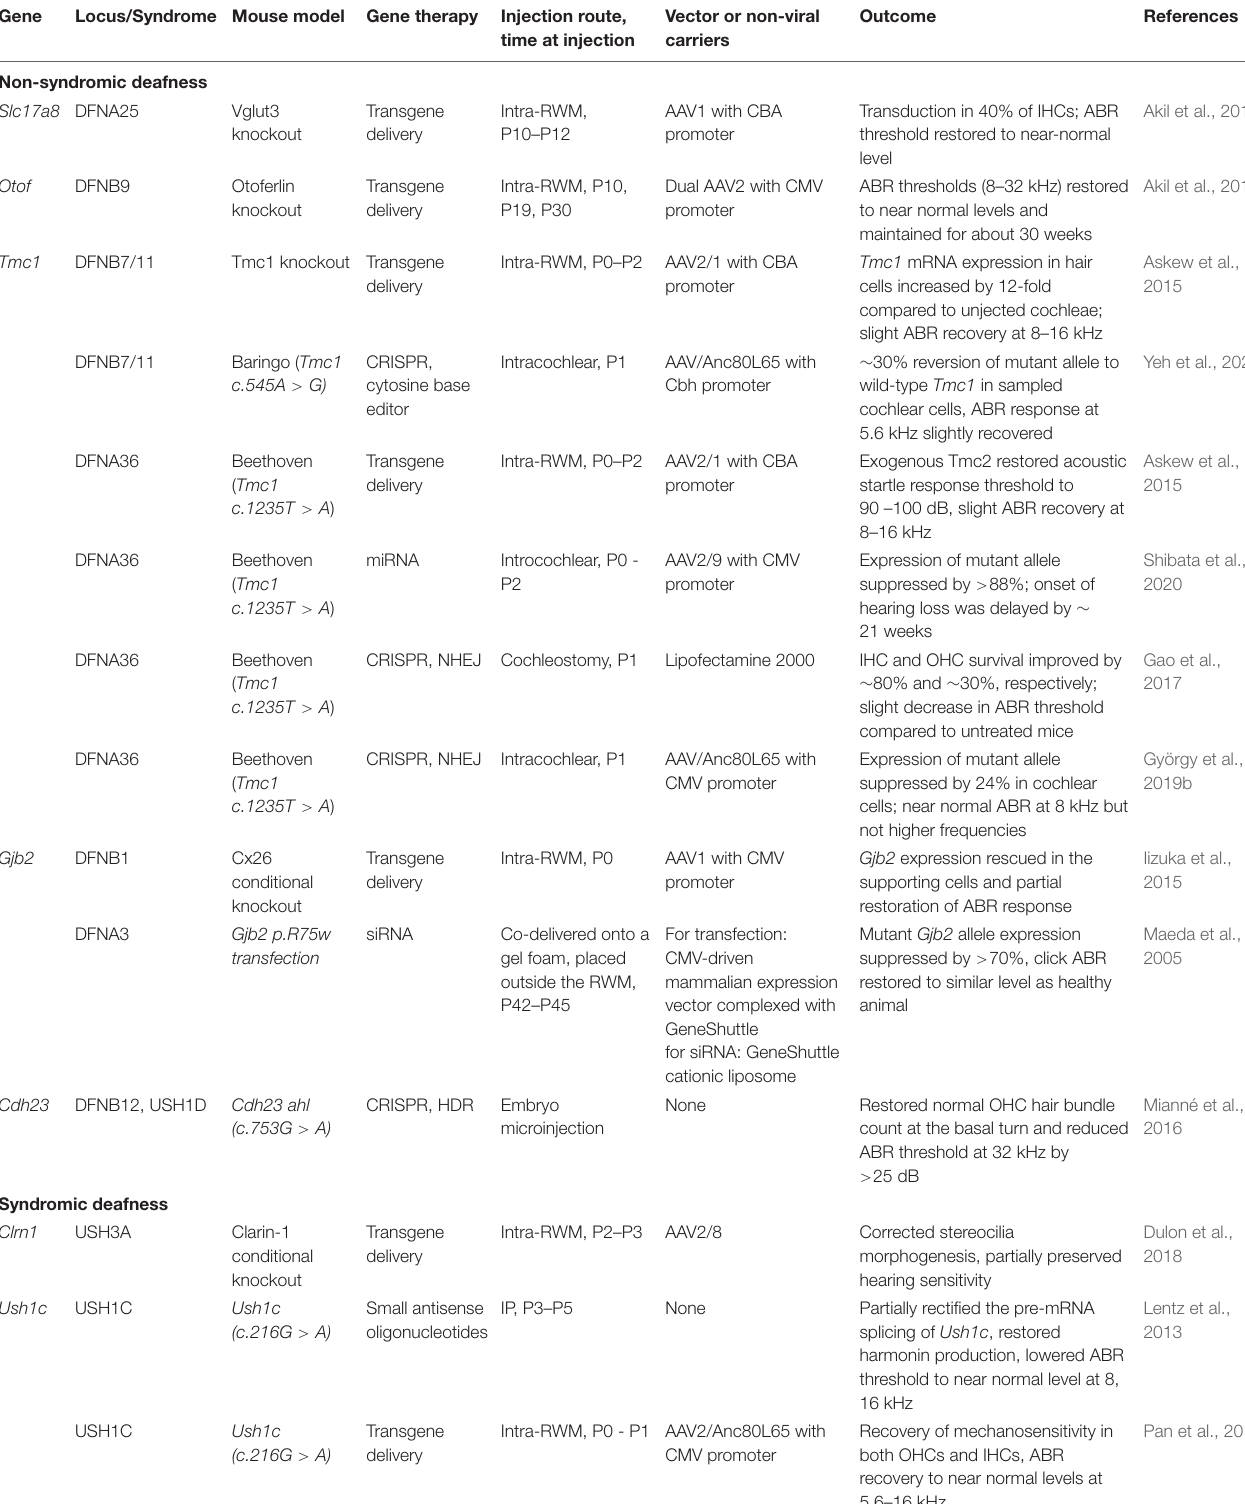
TABLE 1 | A list of genetic SNHL animal studies discussed in this review. Gene Locus/Syndrome Mouse model Gene therapy Injection route,